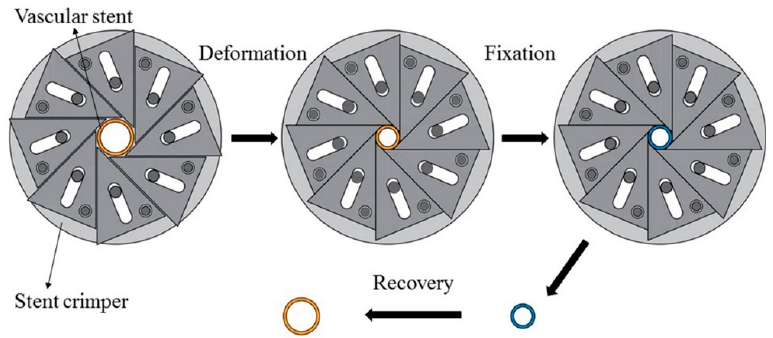
Figure 5. SME experimental process of PLA vascular stent.